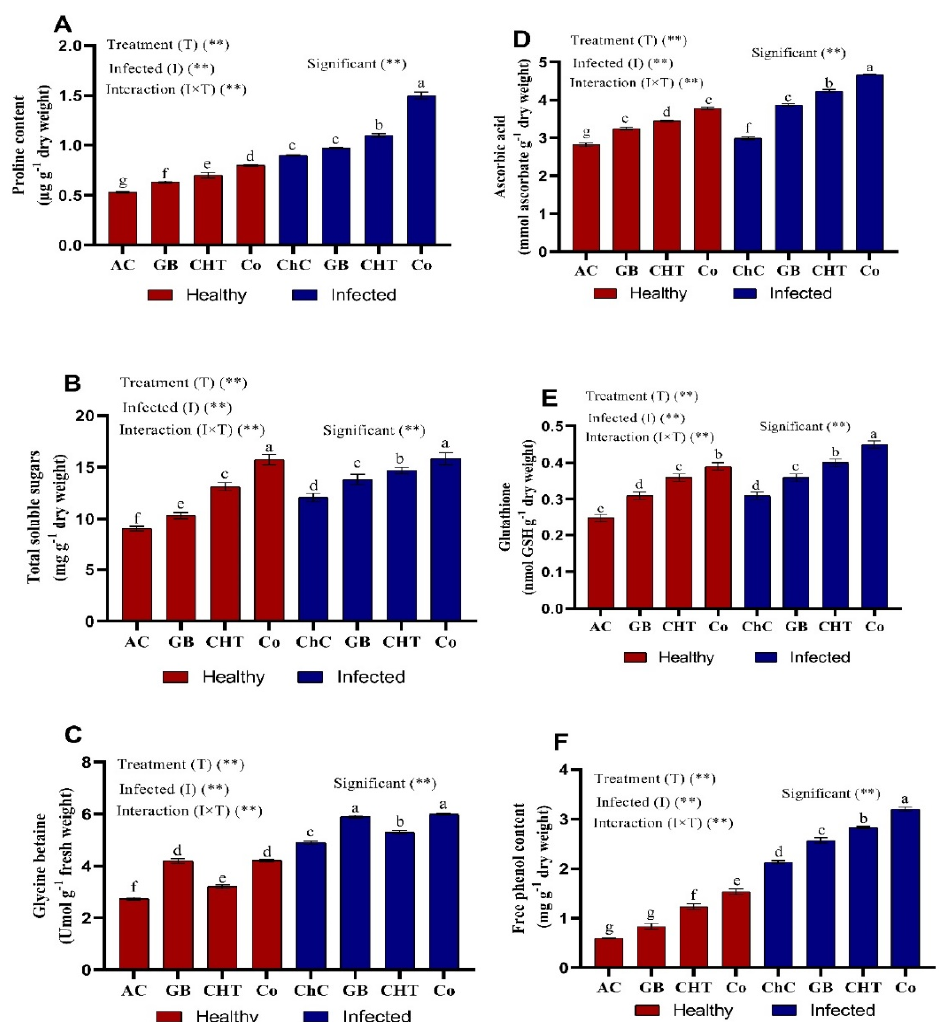
Figure 5. Effect of foliar spray by glycine betaine (GB), chitosan (CHT) and combination (Co) on osmolytes ( A – C ) and non-enzymatic antioxidants ( D – F ) content in leaves of cucumber plant under absolute control (AC) and CMV infection (challenge control, ChC) after 21 days of inoculation. Means with the different letters (a, b, c, d, e, f, g) are significantly different at the 0.05 level among treatments according to Tukey’s test. Vertical bars represent means of three independent determinations ± standard error (SE). ** indicate highly significant difference according to two-way ANOVA with Tukey’s post hoc test.